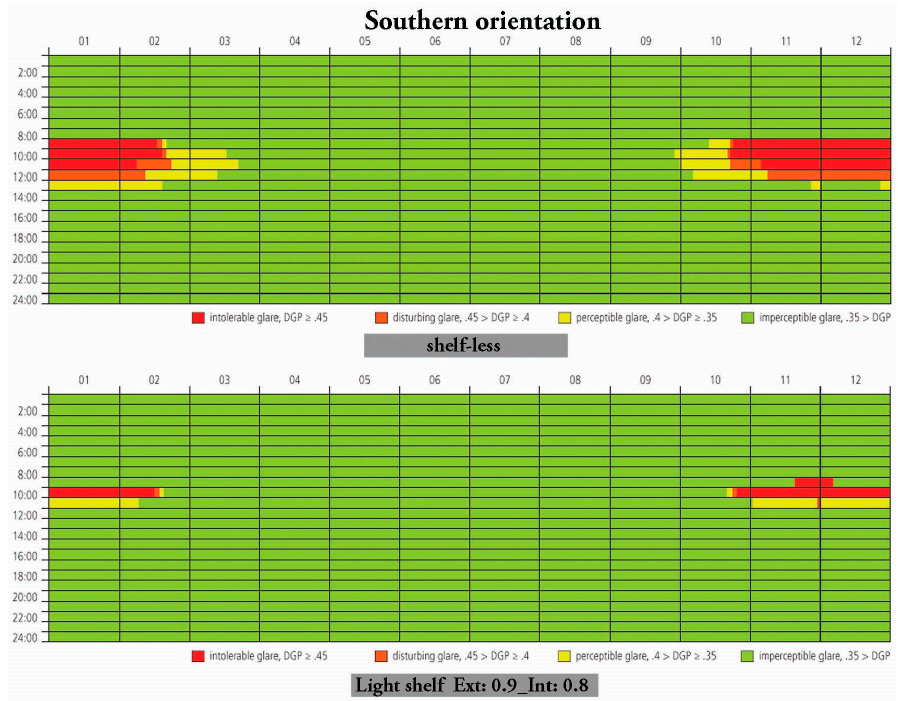
Figure 6. The results of the annual daylight glare probability sample for the southern orientation. Figure 7. The results of the annual daylight glare probability sample for the southern orientation.